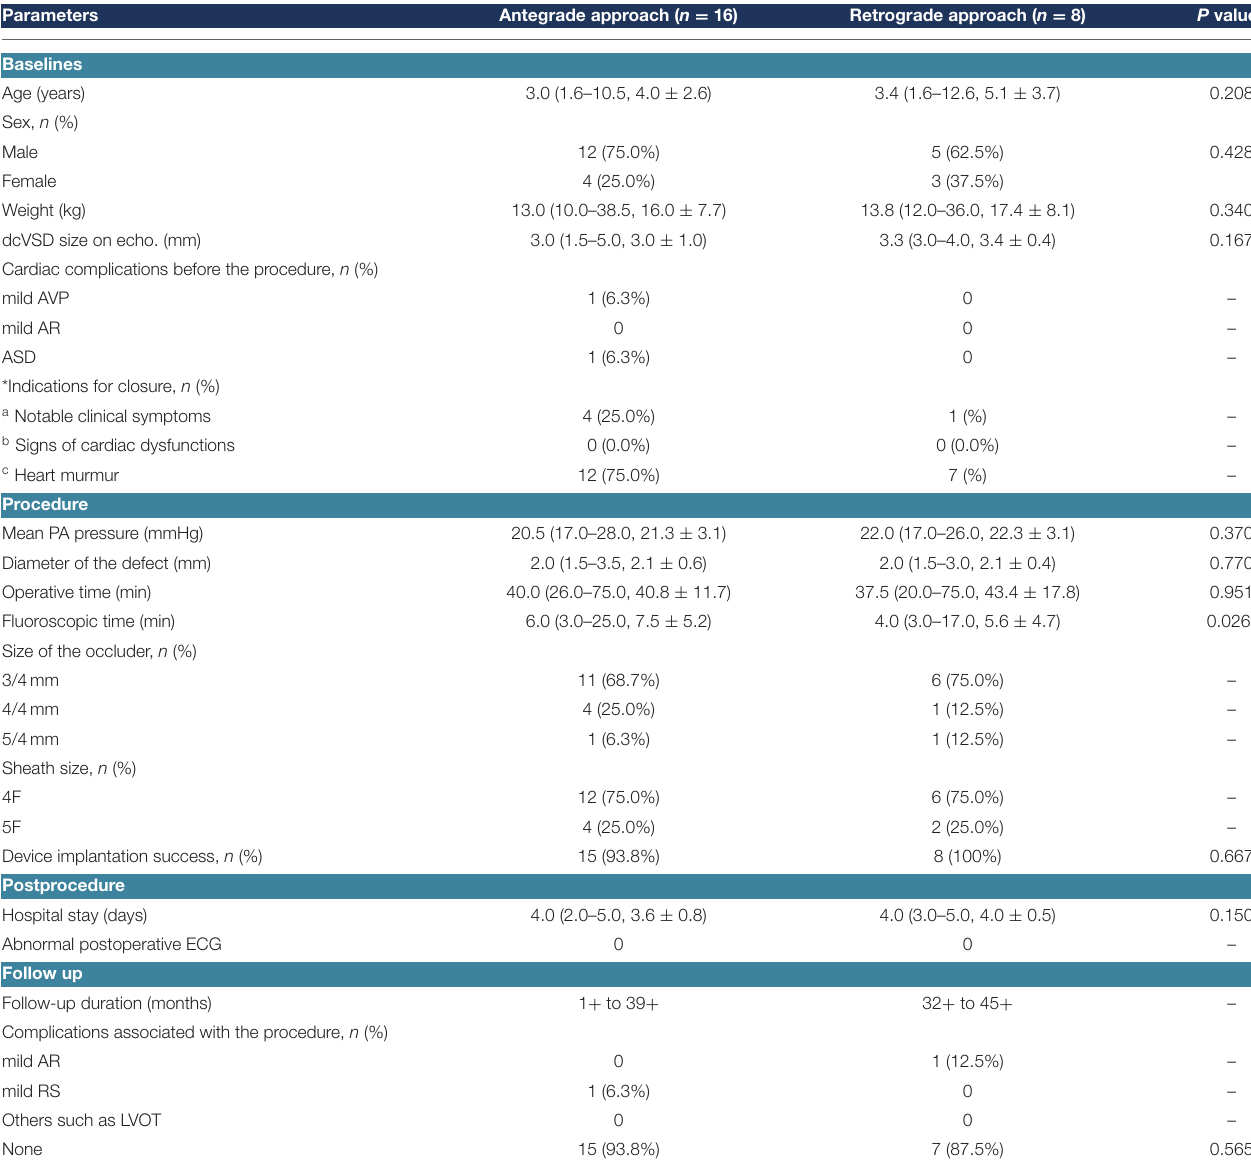
TABLE 2 | Comparison of patient characteristics between using the antegrade approach and using the retrograde approach.